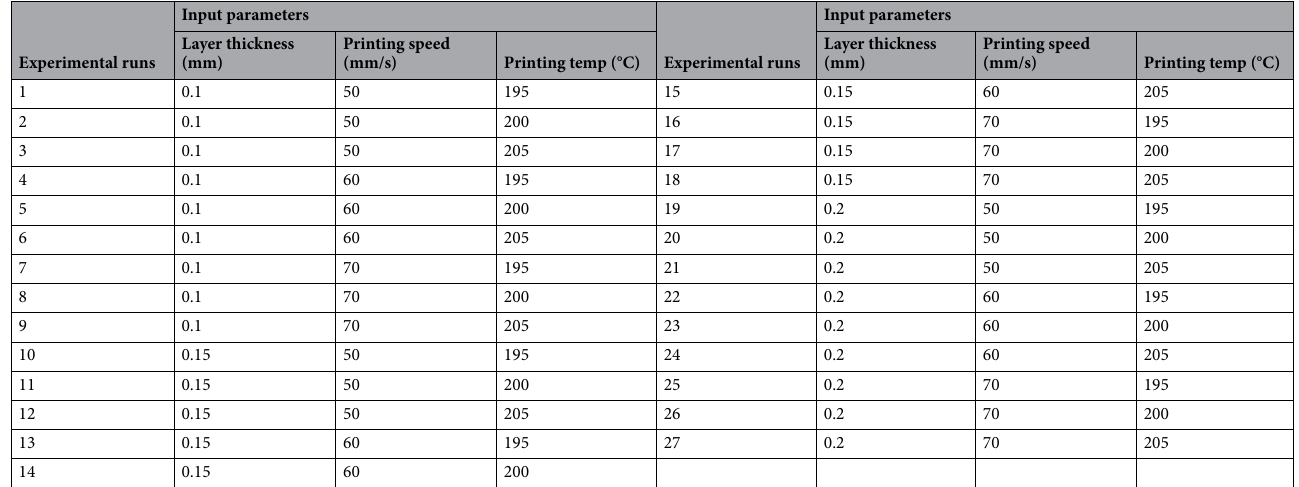
Table 3. Experimental runs for the various combination of input